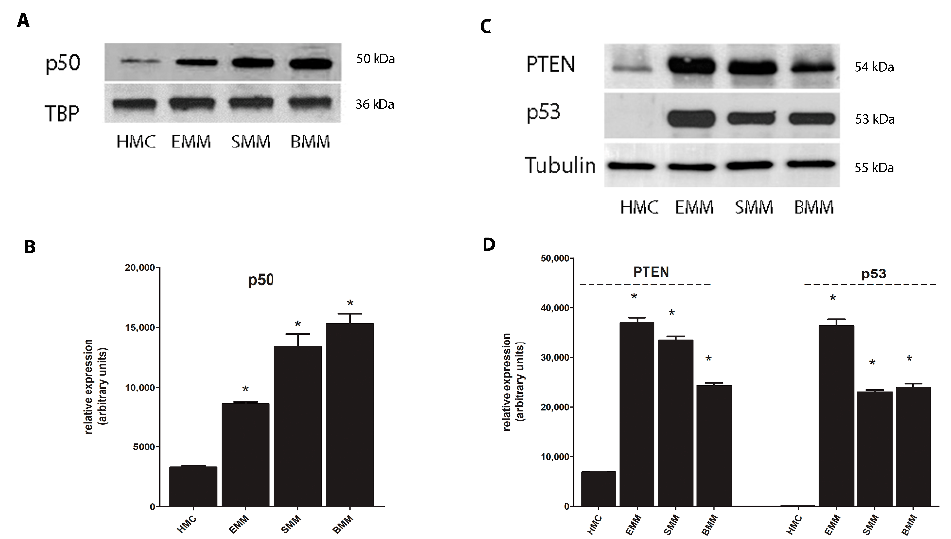
Figure 4. Expression of genes induced by Ref-1 in MPM cells. ( A ) Western Blot of nuclear p50 active subunit of NF-kB and TBP protein in HMC, EMM, SMM, and BMM cells, and ( B ) the relative densitometric analysis ( n = 3, * p < 0.001). ( C ) Western Blot of cytosolic p53, PTEN and Tubulin proteins in HMC, EMM, SMM, and BMM cells, and ( D ) the relative densitometric analysis ( n = 3, * p < 0.001).